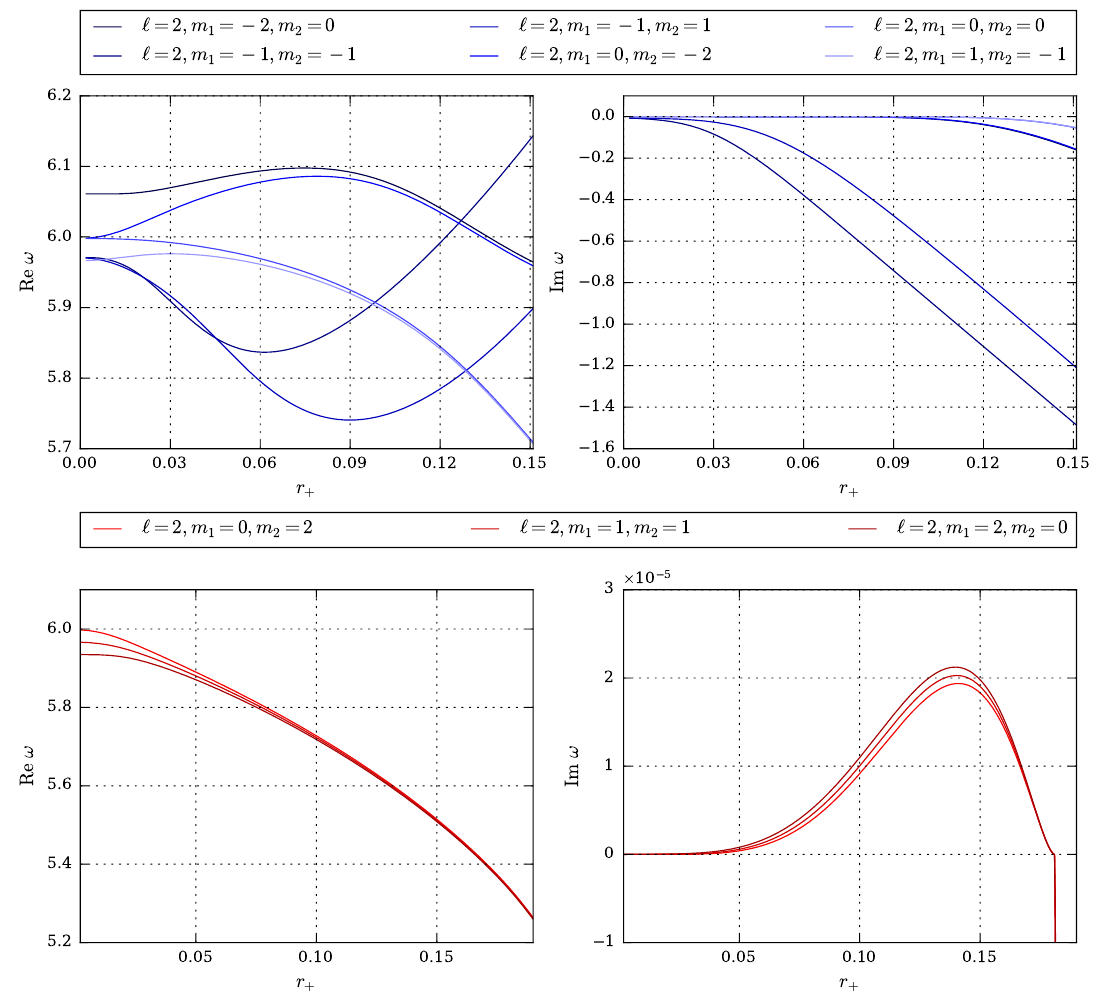
− a 2 = 0 . 001 as 1 2